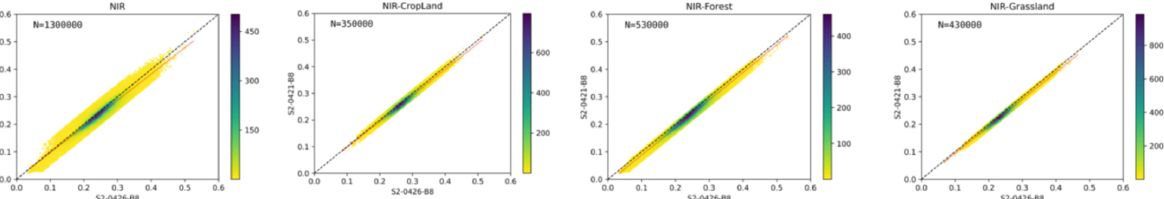
Figure 11. Comparison of the apparent reflectance scatter points for land cover types correction and whole test area correction. N is the number of image pixels, the black dashed line is the 1:1 line, and the red solid line is the regression line of the scatter plot. From left to right: Whole test area, cropland, forest, grassland.